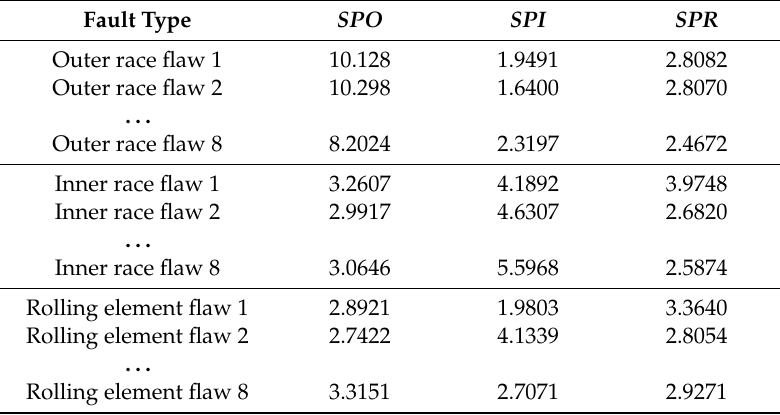
Table 6. DSP for bearing fault isolation (verification step).